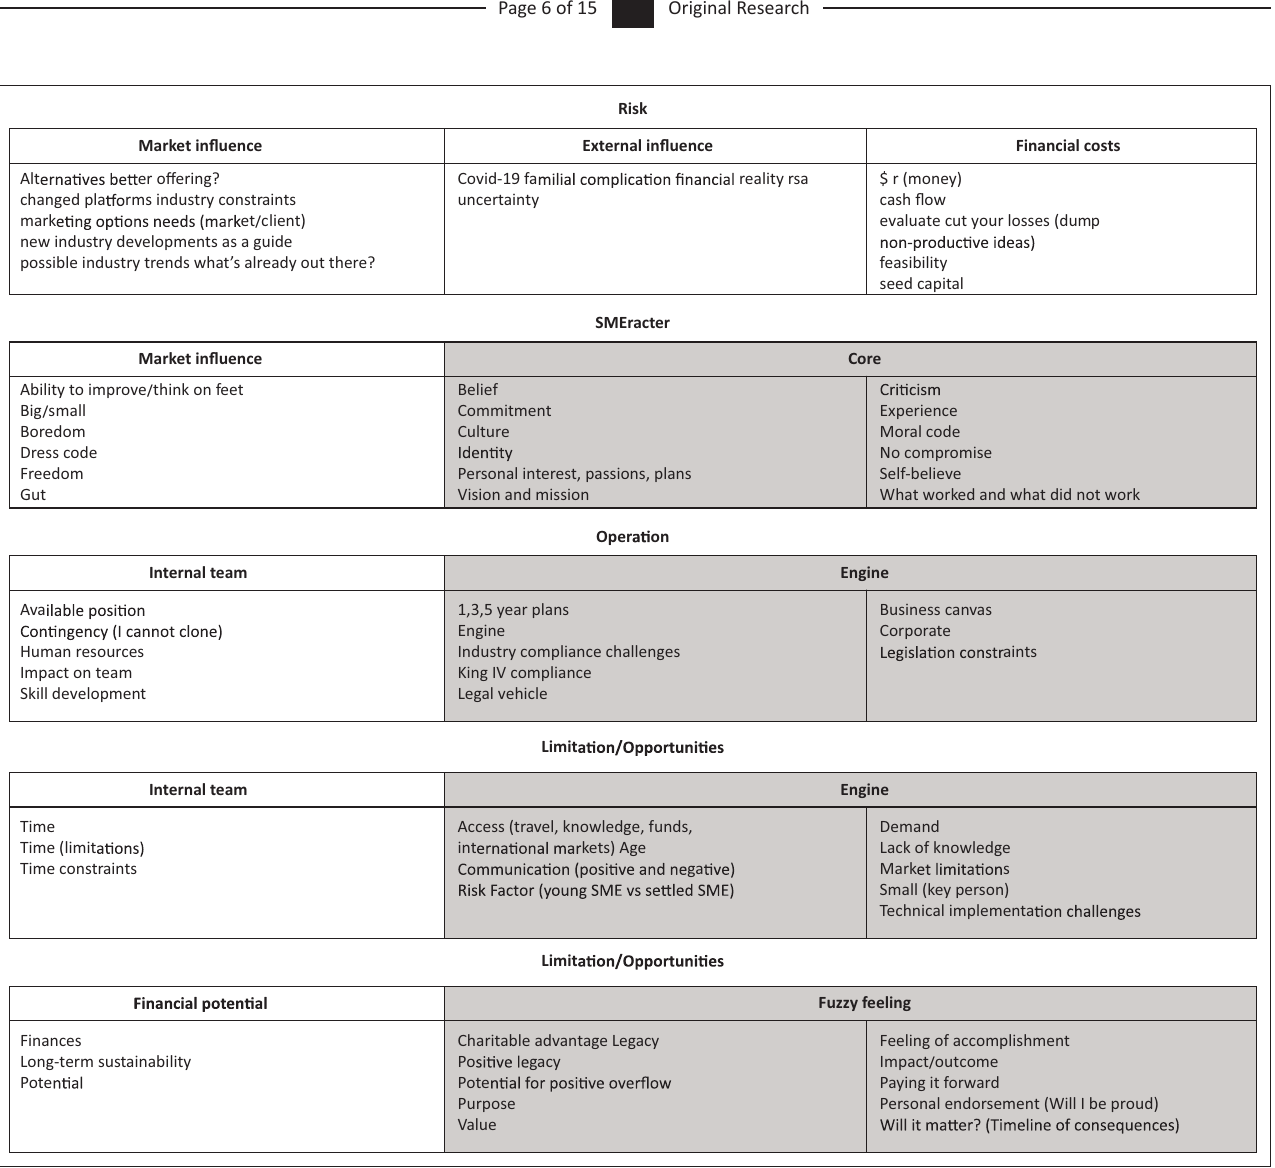
FIGURE 1: Reflection notes, themes and